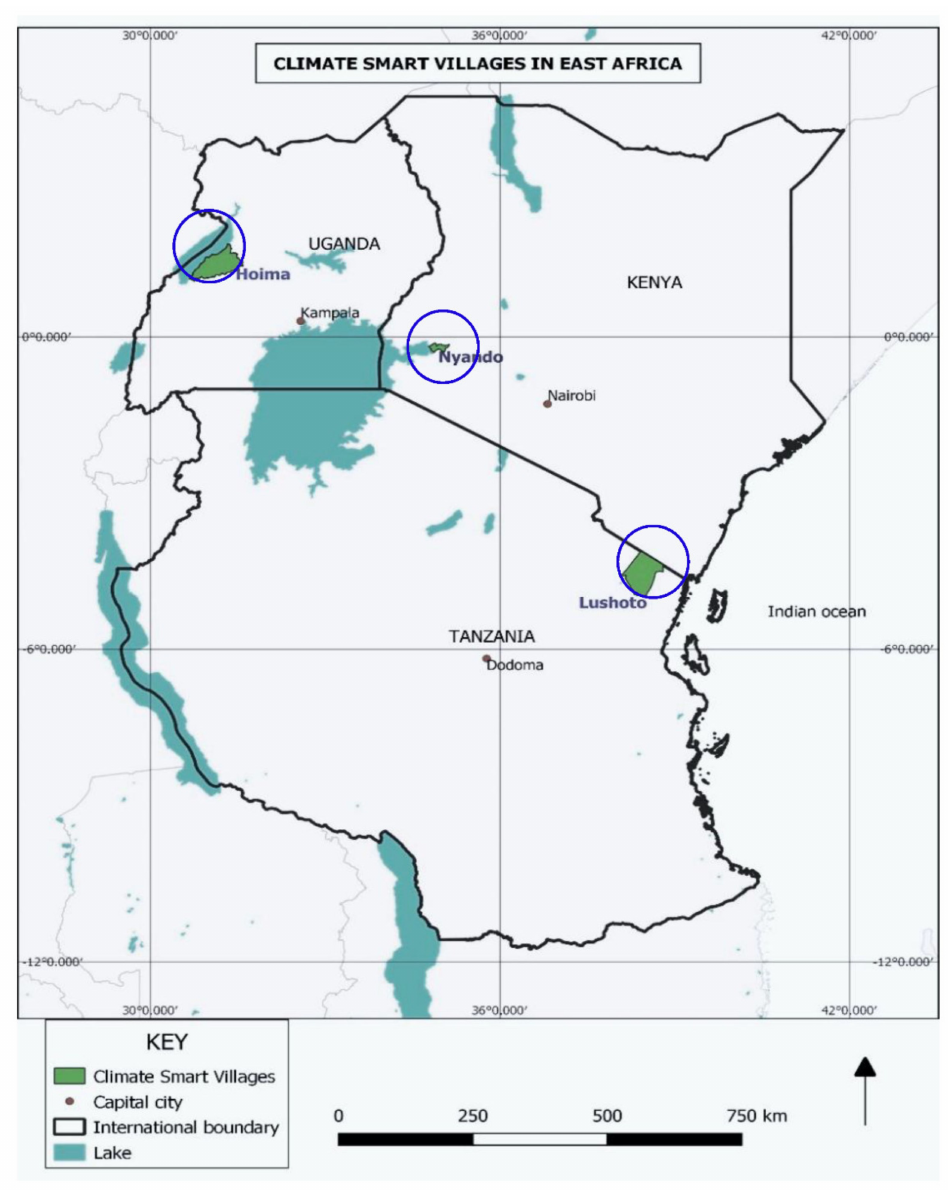
Figure 1. Climate-smart village research sites in Hoima, Nyando, and Lushoto. Source: Ambaw et al. [18]. The Lushoto CSV has a mountainous topography with overcultivated agricultural land that is experiencing extreme population pressure, increased poverty, and slow